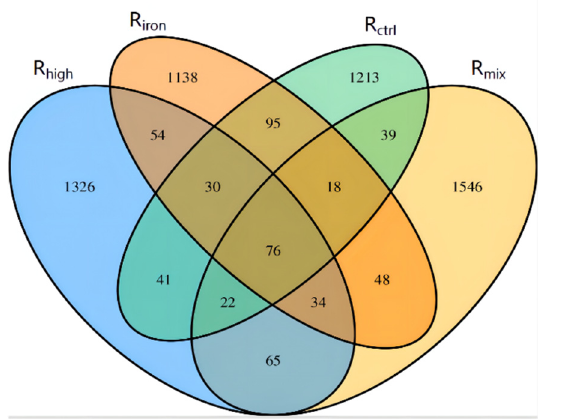
Figure 3. pH levels of the four reactors.